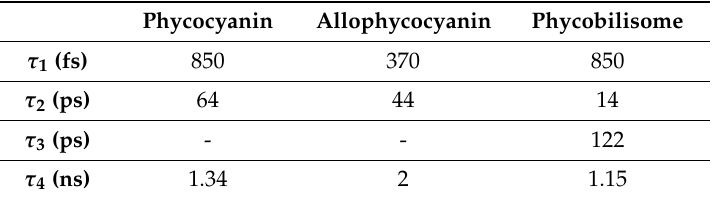
Table 1. Transient absorption decay times obtained for each investigated system.